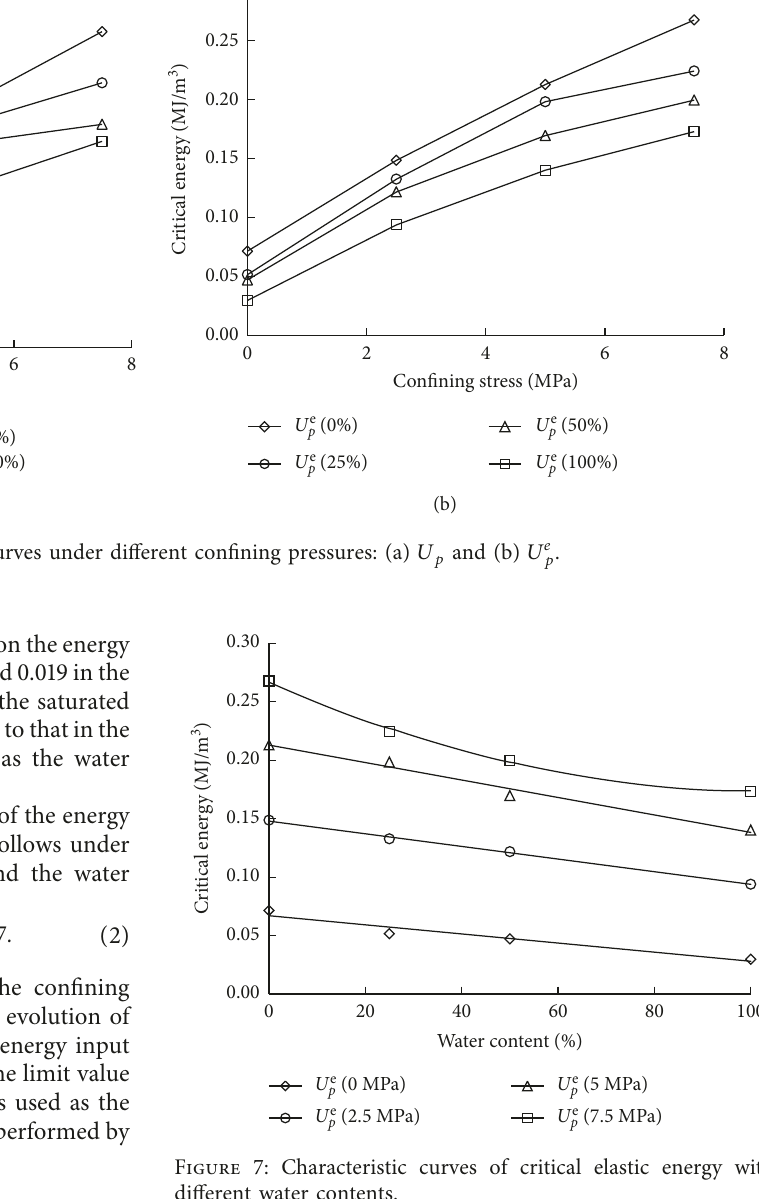
Figure 7: Characteristic curves of critical elastic energy with different water